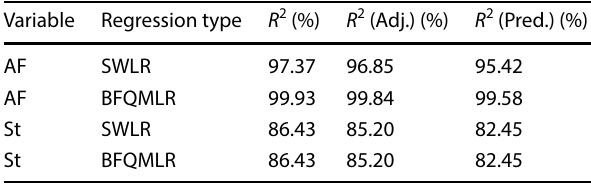
Table 8 Results of ANOVA for R 2 , R 2 (Adj.) and R 2 (Pred.)